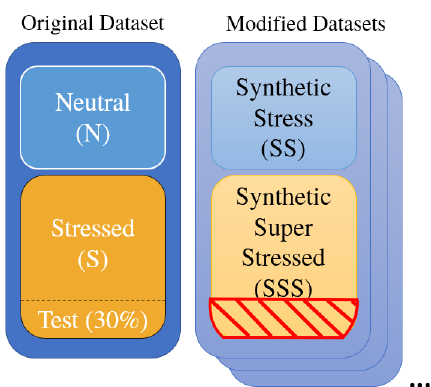
Figure 4. Schematic of Original and Modified Datasets. On the left side, we represent in a block basis the original dataset, composed by neutral and stressed samples. In this case, we used the 30% of the examples of the the stressed collection as the Test set for later experiments. On the right, we represent a diagram of one of the synthetically stressed sets, where the 30% of data used before as Test was removed to obtain more reliable results. There are several synthetic datsets, one per modification